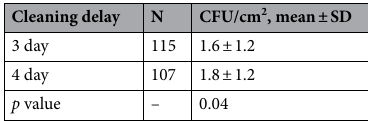
Table 2. CFU/cm 2 3 days versus 4 days since last cleaning.